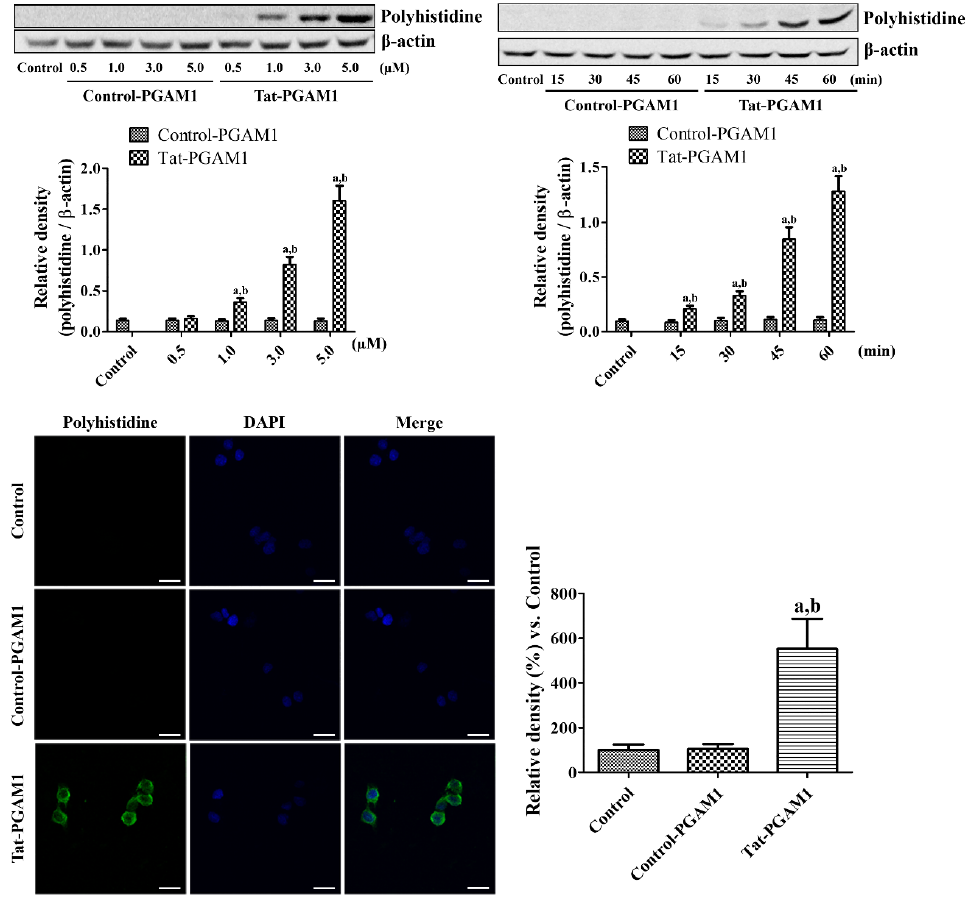
Figure 1. Intracellular delivery of Trans-activator of transcription-phosphoglycerate mutase 1